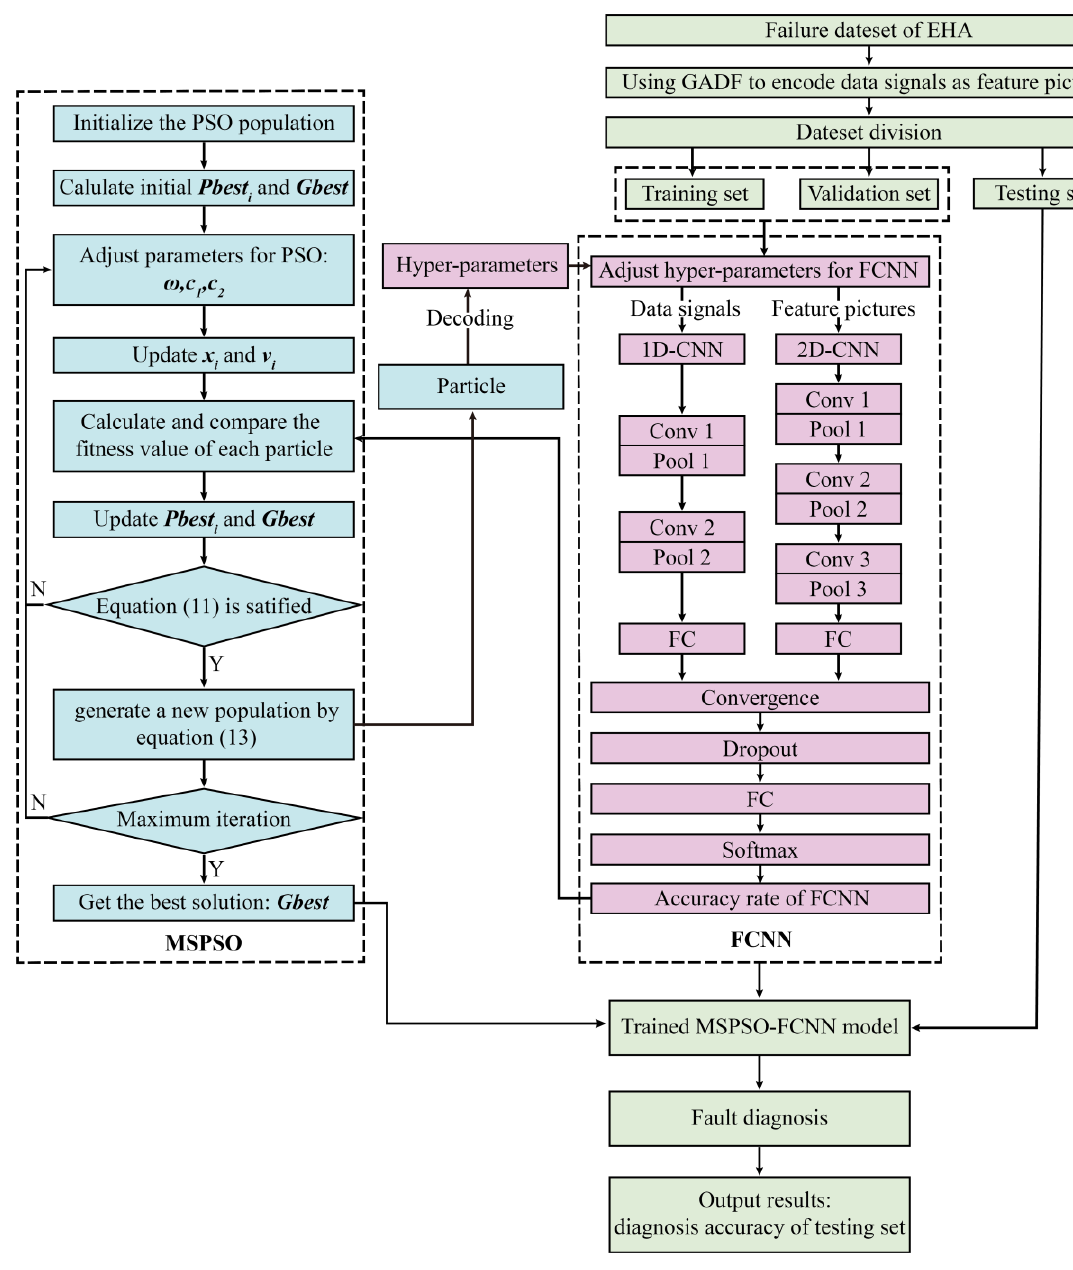
Figure 8. The framework of the MSPSO-FCNN fault diagnosis model.